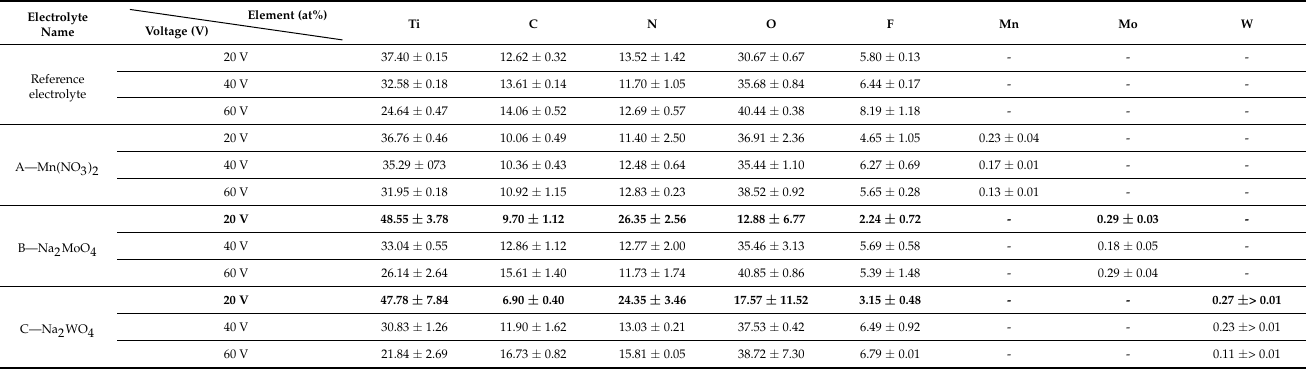
Table 4. The average element content (at %) in the ATO fabricated in different electrolytes as a function of the applied anodization voltage, measured by